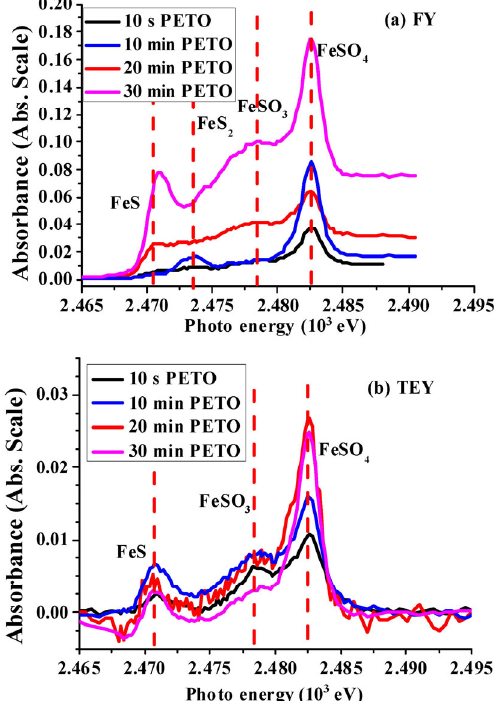
Fig. 5 Sulfur K-edge (a) FY mode and (b) TEY mode XANES spectra for DPS-tribofilm in PETO with different baking